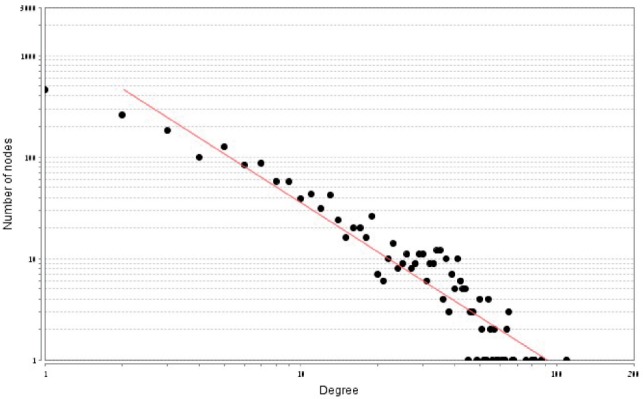
Degree distribution of the co-evolutionary network on a log–log scale. All 4,593 COGs are ranked according to their degree. In total, 1,940 COGs have at least one connection.